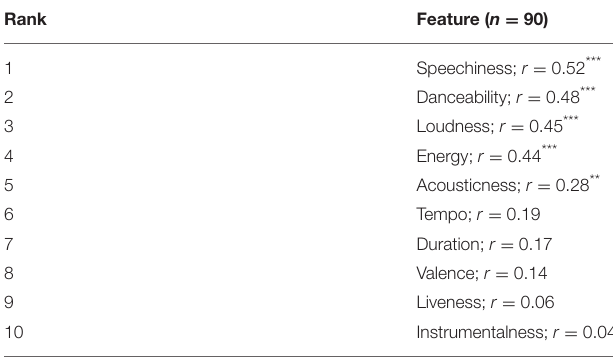
TABLE 5 | Table showing the ranked order of features.